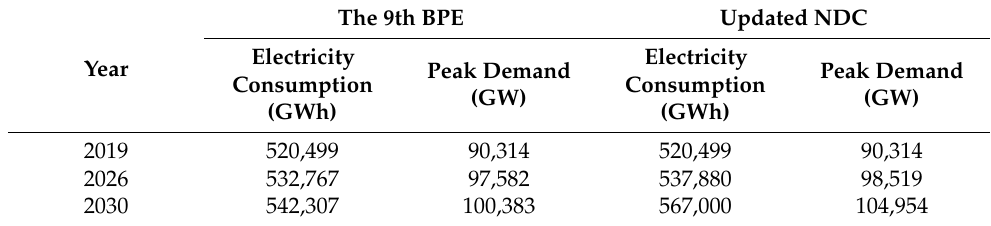
Table 3. Peak demand and electricity consumption of 9th BPE and NDC.